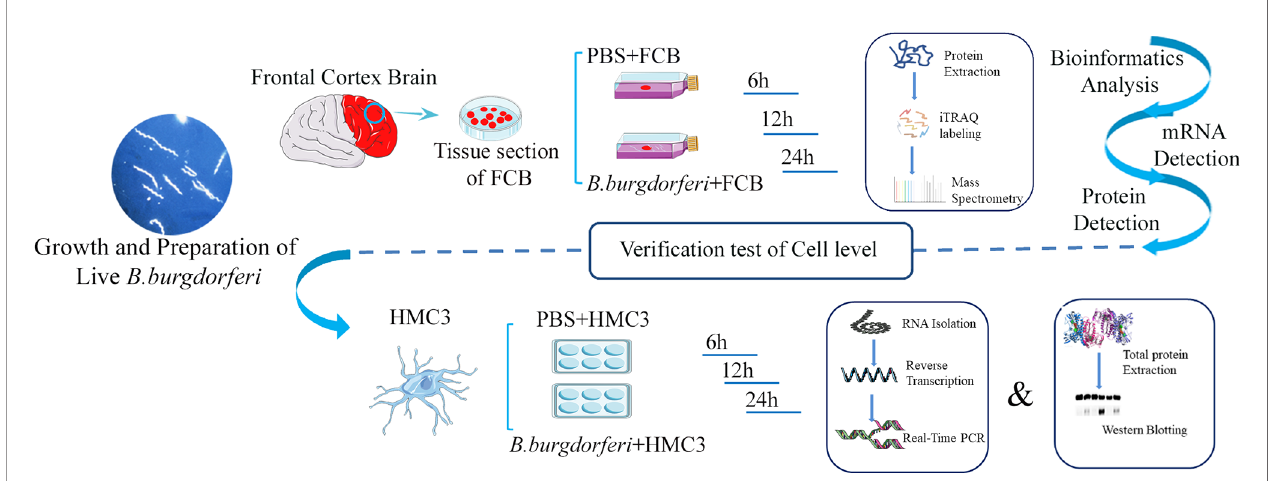
FIGURE 1 | Schematic illustration of the experimental design contains the experiment with explants from the frontal cortex of rhesus macaque brains co-cultured with live Bb and validation experiment using the human microglia HMC3